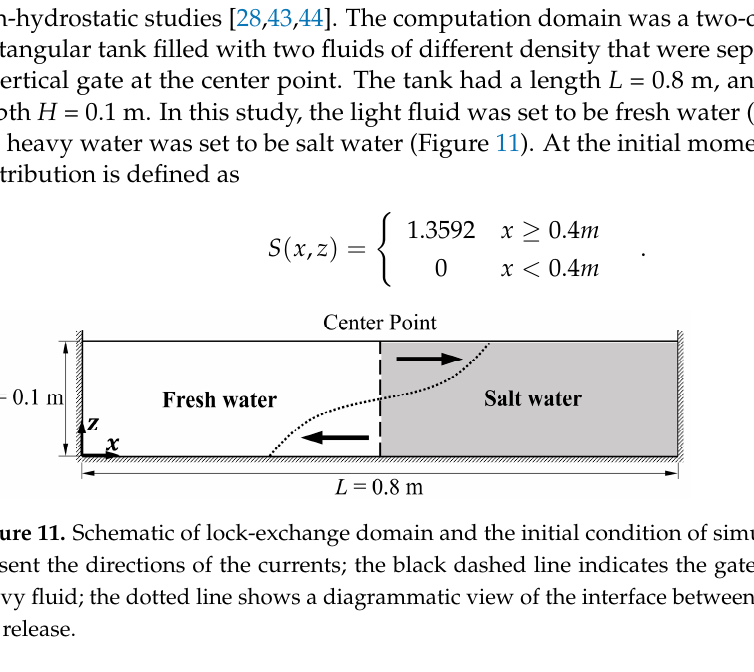
Table 2. A summary of grid settings in the lock-exchange case.